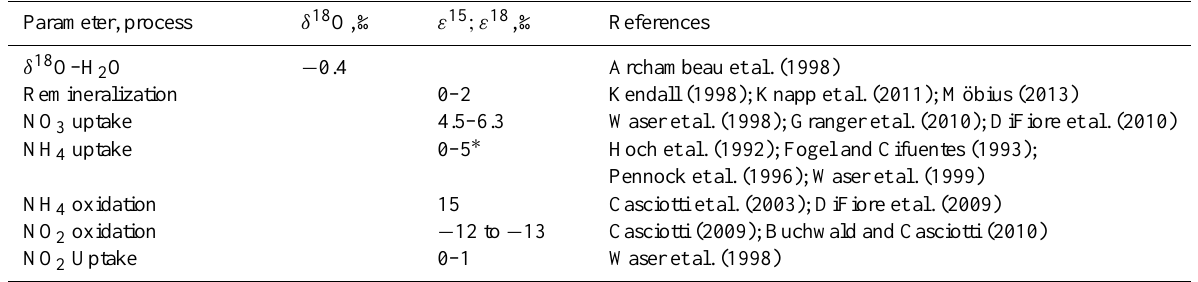
Table 2. Considered isotopic discrimination factors for model calculations.